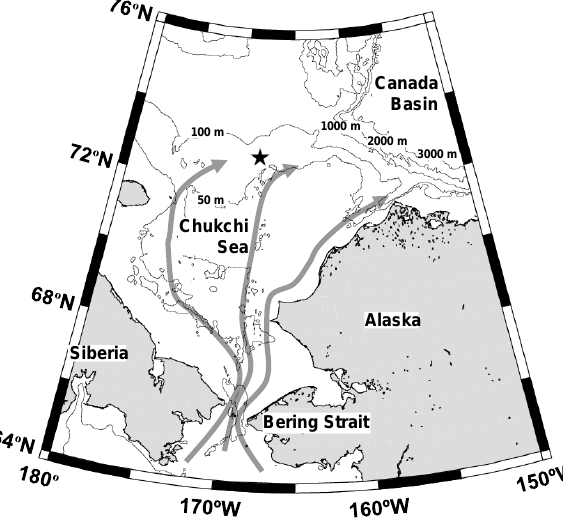
Figure 1. Location of the sampling station in the Chukchi Sea from 10 to 25 September 2013. Arrows indicate the major current flows in this region (cf. Grebmeier,